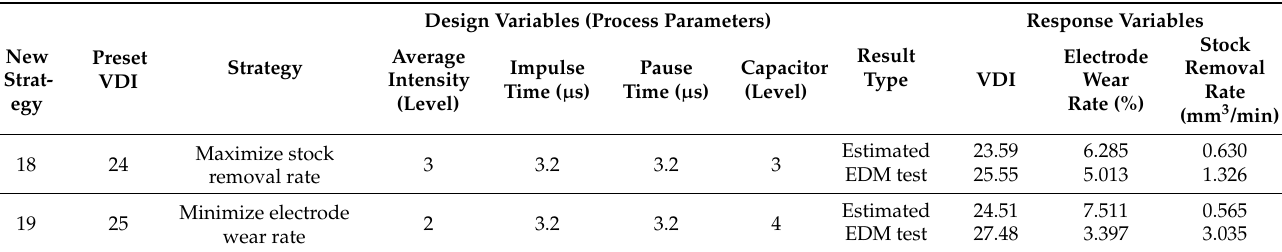
Table 11. Comparative results of new strategies 18 and